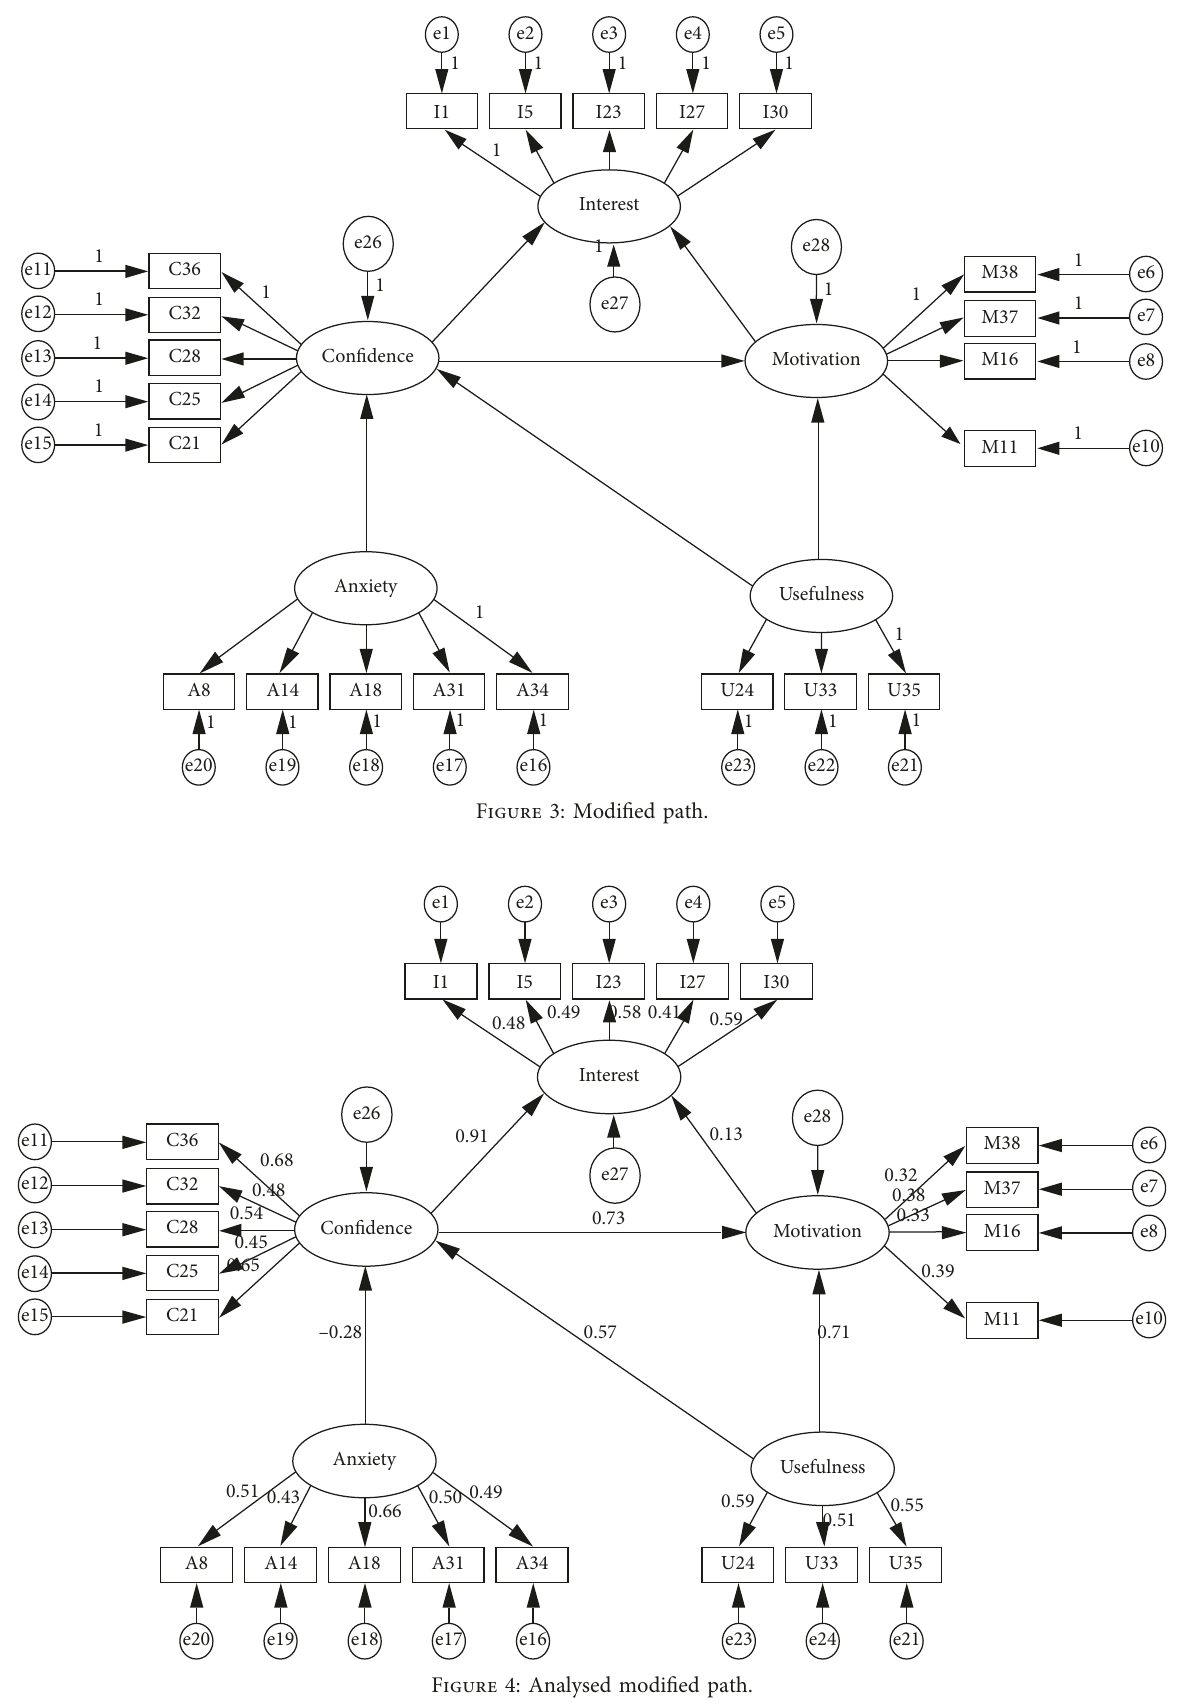
Figure 4: Analysed modified